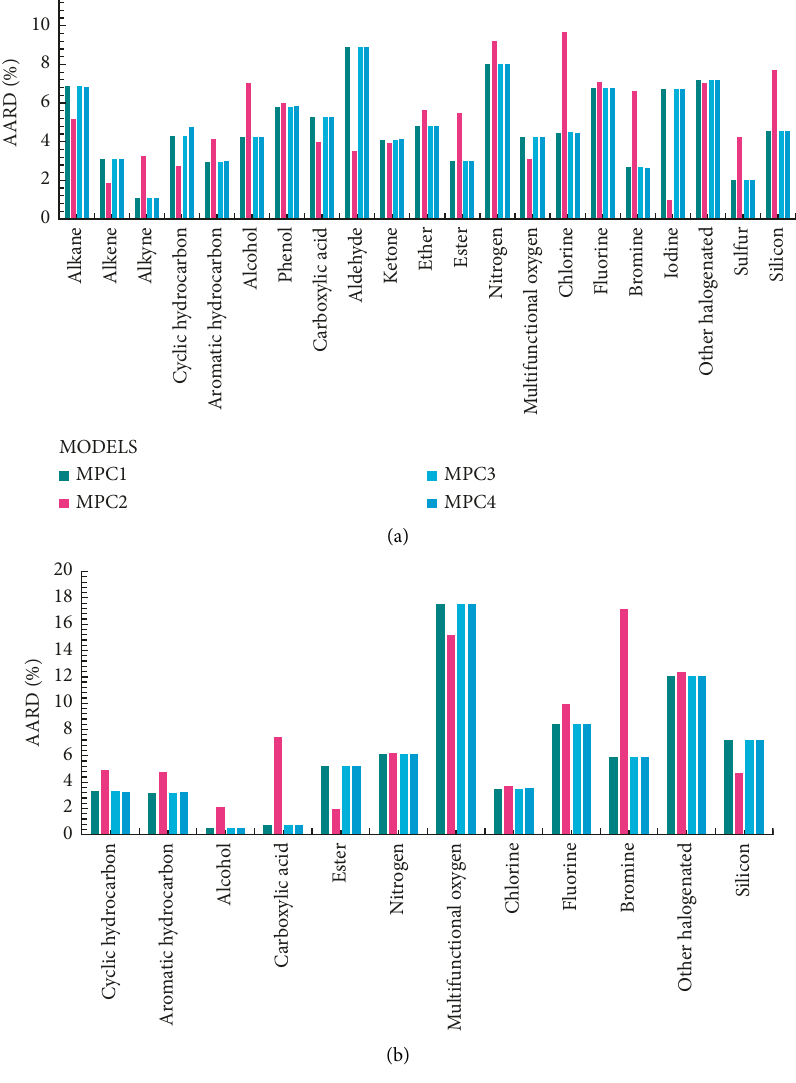
Figure 6: AARD for the calculation of critical pressure of pure compounds using different first-order GCMs. (a) Correlation and (b)